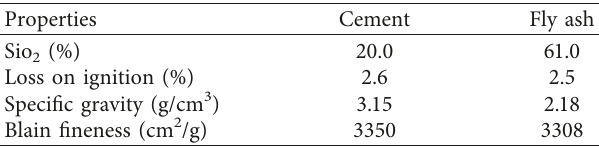
Table 1: Physical properties of ordinary Portland cement and fly ash.